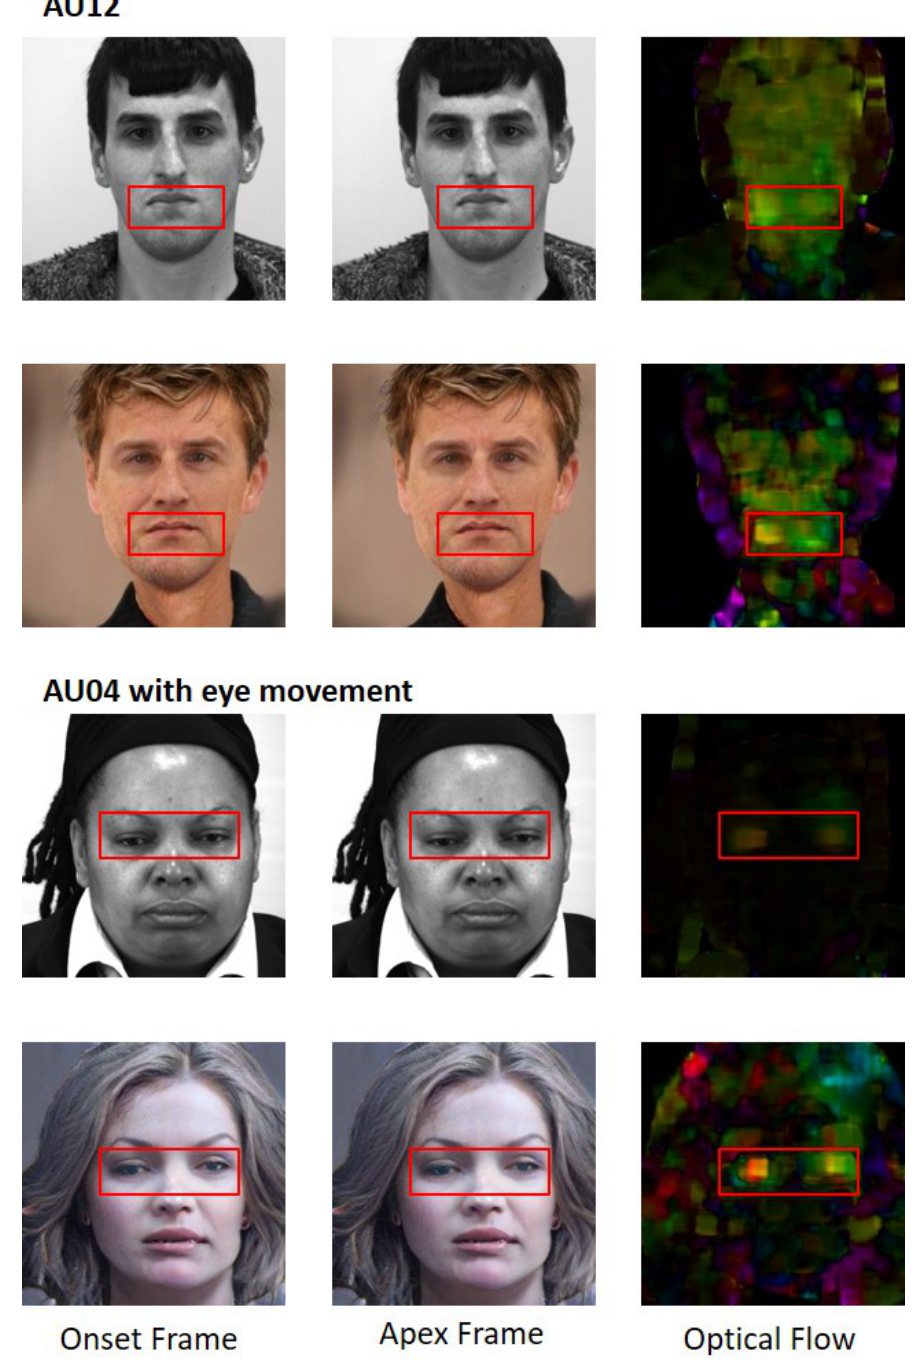
Figure 6. Optical flow comparison of onset and apex frames between original and synthetic MEs. Each respective AUs are shown in the red bounding boxes . ( Top ) For movement 007_6_5, AU12 is involved. ( Bottom ) For movement 030_5_1, AU4 and slight eye movement are involved. The hue represents direction, while the brightness represents intensity of the movements. Note: Original images were scaled to 256 × 256 pixels for fairer